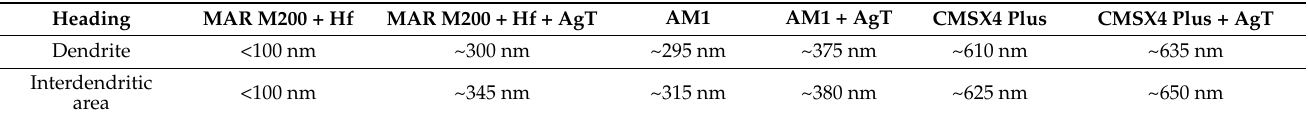
Table 4. Image analysis measurements of the equivalent diameter of γ (cid:48) -precipitates.